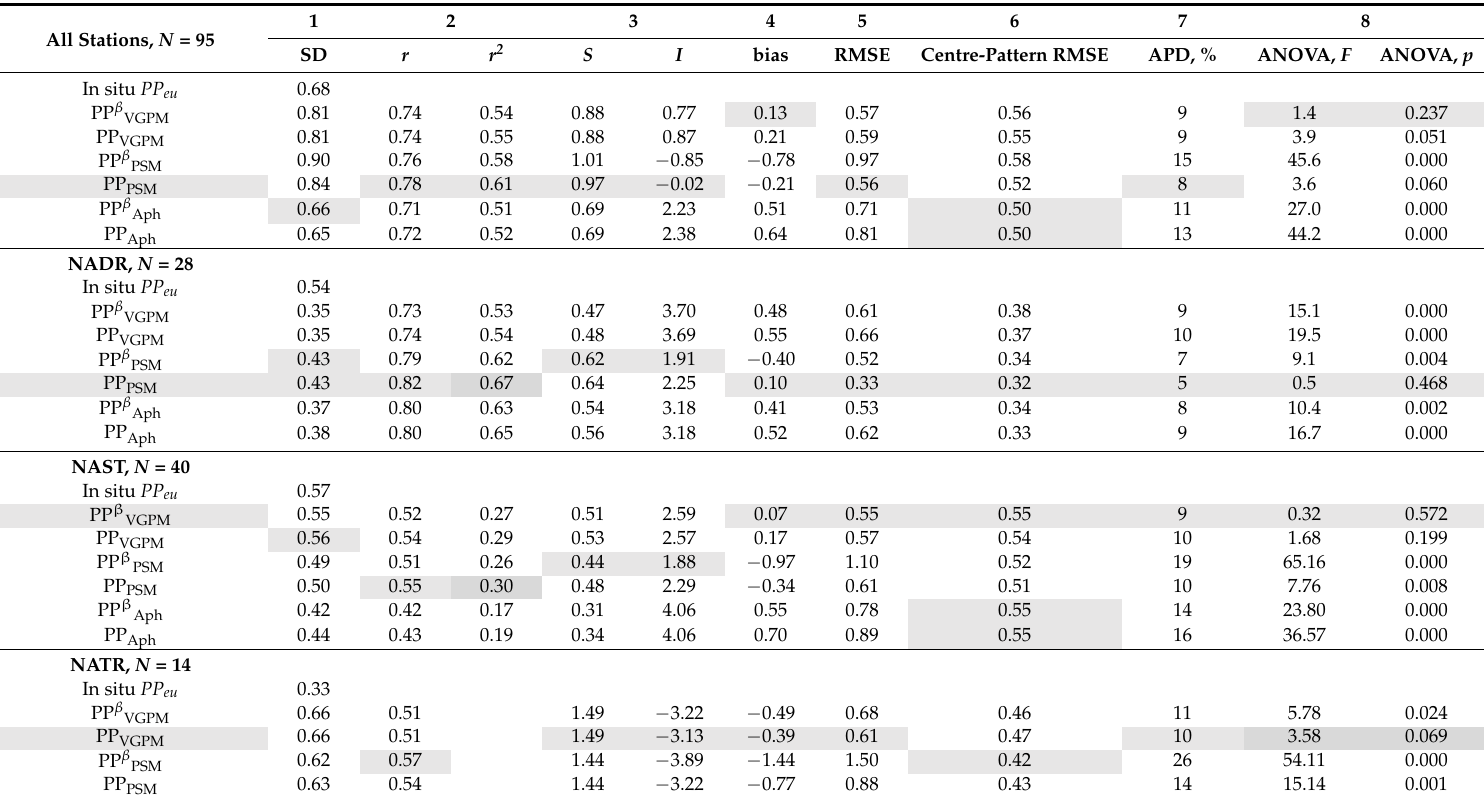
Table A3. Validation statistics for each model for the whole region and for individual biogeographical provinces using eight day composite OC-CCI data. The numbers at the head of the table indicate statistics for one test. The most significant statistical values are highlighted in grey. r is the Pearson or Spearman pair correlation coefficient (For N > 28, Pearson was used; for N < 28 Spearman was used, but r 2 was not computed), r 2 is the coefficient of determination, SD is the Standard Deviation, RMSE is the Root Mean Square Error, S is the Slope, I is the Intercept of the linear regression coefficients, APD is the Absolute Percentage Deviation, and F and p are ANOVA (Analysis of variance) coefficients. Those models, for which the significance of r was more than 0.1, were not included into the analysis and are not presented in the Table for summer stations in NAST ( N = 16) and ARCT ( N = 12), autumn stations in NADR ( N = 6) and NAST ( N =